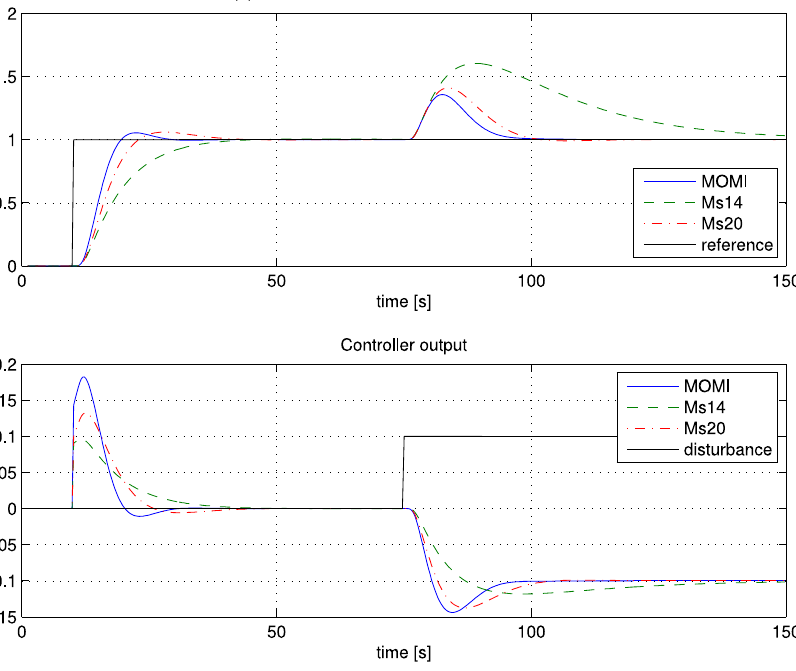
Figure 16. Closed-loop responses of G P4 process. PI controllers were tuned by MOMI, Ms14, and Ms20